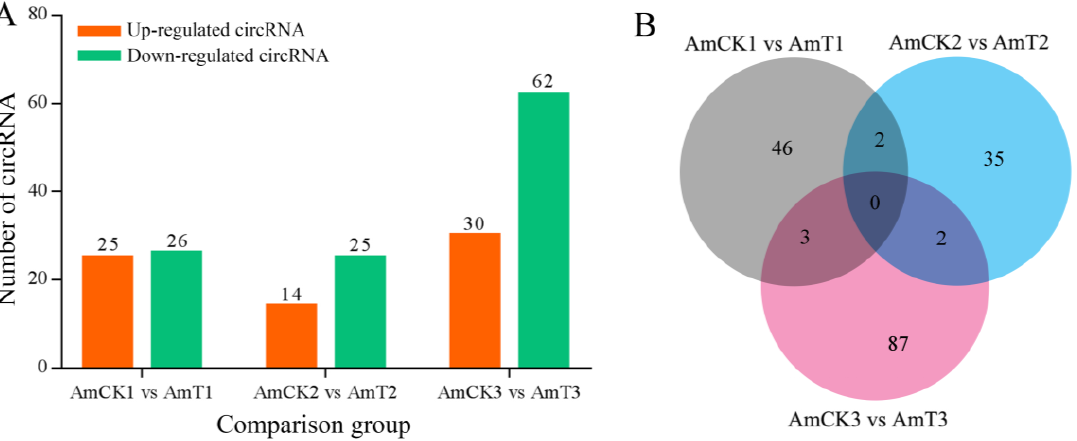
Figure 2. Number statistics ( A ) and Venn diagram ( B ) of DEcircRNAs in three comparison groups.